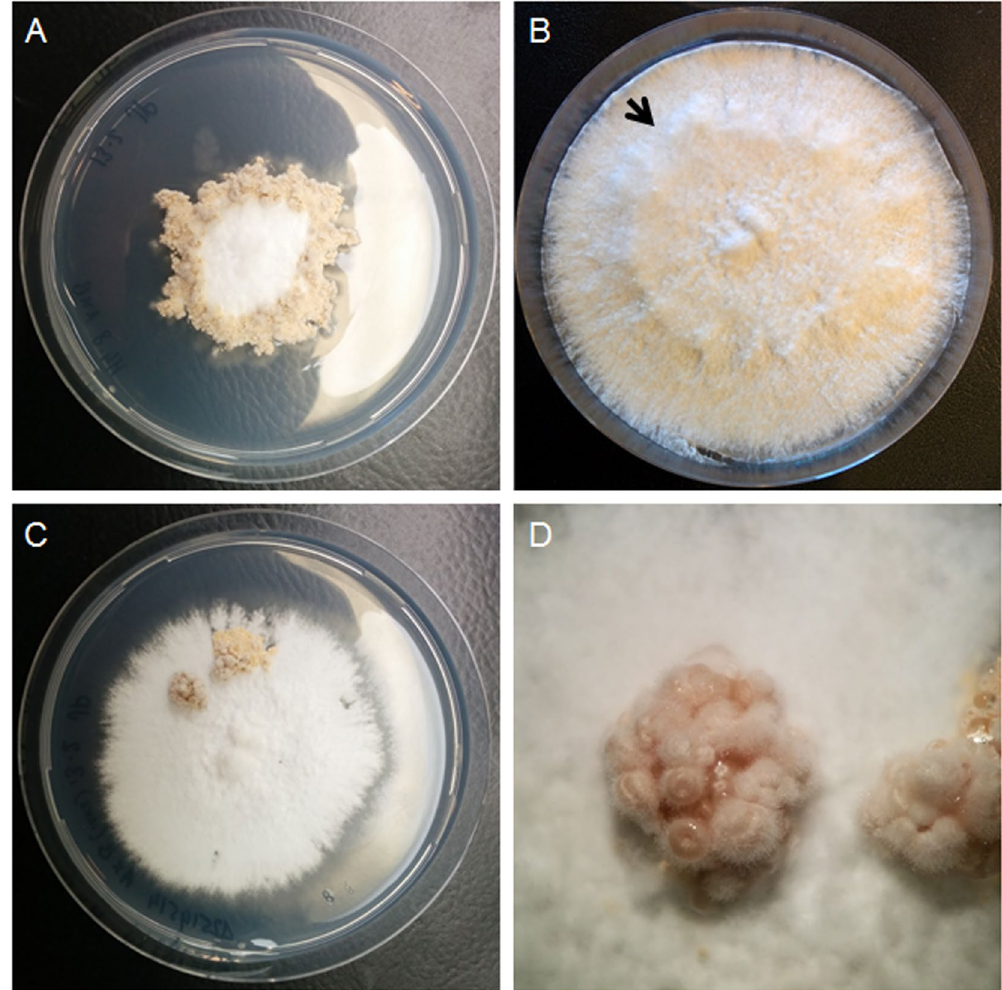
Figure 4. Aerial growth of dikaryotic colonies of H4-8 ( A ) and Δ tea1 ( B , C , D ). Strain Δ tea1 Δ tea1 produced less dense and high aerial hyphae when transferred to light ( B ) and only forms small clusters of fruiting bodies ( C and D ). Arrow indicates the transition from dense aerial hyphae production to thinner aerial hyphae production upon light